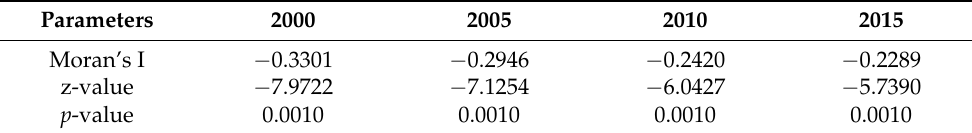
Table 3. Parameter values of bivariate spatial correlation analysis.